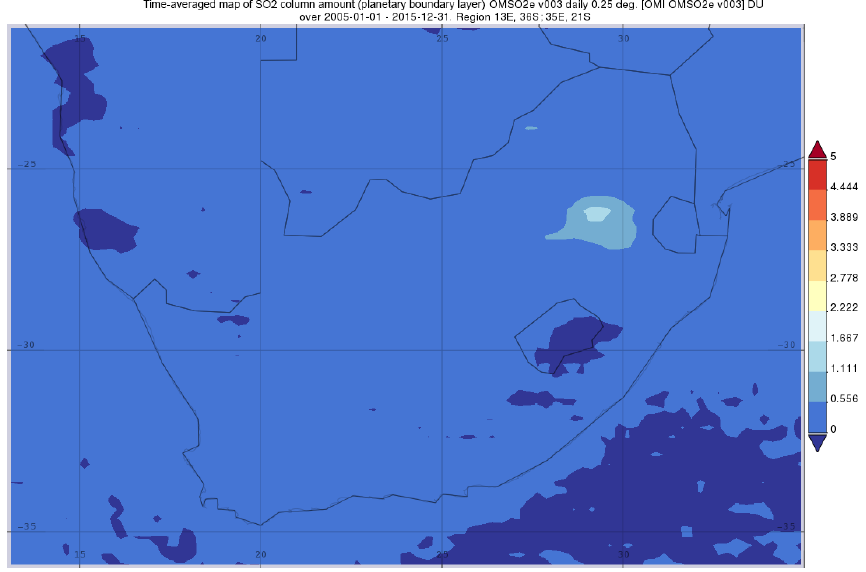
Figure A5. Geospatial map of southern Africa depicting the SO 2 column amount averaged over the period 2005 to 2015 obtained using the data from the NASA Giovanni satellite (https://giovanni.gsfc.nasa.gov/giovanni/, last access: 20 June 2019). OMI: Aura Ozone Monitoring